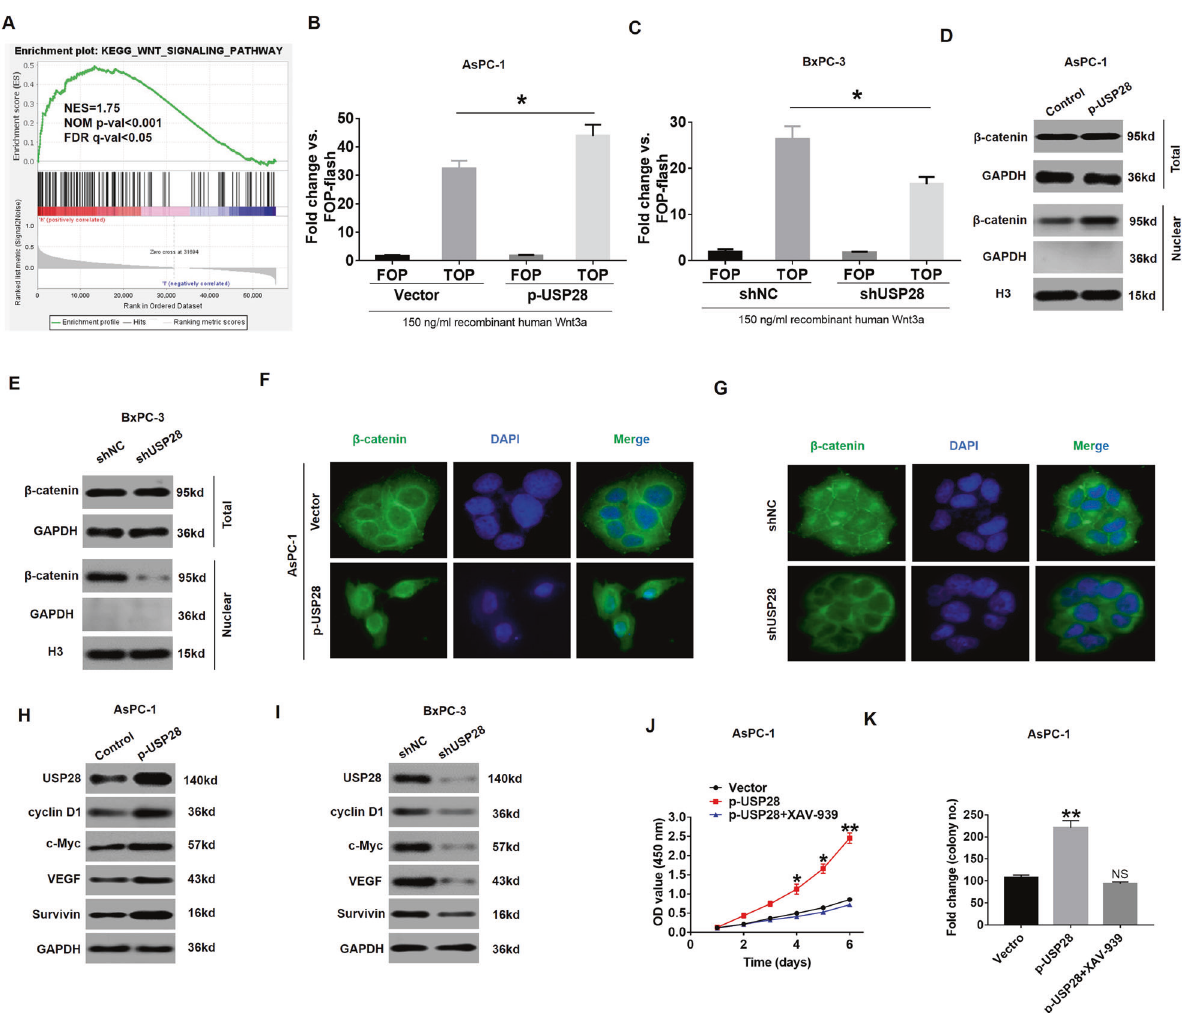
Fig. 4 USP28 activates Wnt/ β -catenin signalling pathway in PC cells. A GSEA comparing the gene sets of Wnt targets in USP28 high PC patients. Data were obtained from TCGA database. NES means normalized enrichment score. B , C After treatment with 150 ng/ml of recombinant human Wnt3a, the relative luciferase activity levels in cells transfected with TOP- fl ash and FOP- fl ash vectors in USP28- overexpression AsPC-1 cells ( B ) or USP28-silencing BxPC-3 cells ( C ) are shown. Data represent mean ± SD of triplicate experiments and were statistically analysed with Student ’ s t test, * P < 0.05. D , E The total and nuclear protein levels of β -catenin were assessed by western blotting in USP28-overexpression AsPC-1 cells ( D ) or USP28-silencing BxPC-3 cells ( E ). GAPDH and Histone 3 were used as a loading control, respectively. F , G IF analysis of the nuclear levels of the β -catenin in PC cell transduced with p-USP28 or shUSP28 plasmid. The green signal represents the staining of the corresponding protein, and the blue signal represents the nuclear DNA staining by DAPI. H , I Western blotting showing the protein expression of USP28, cyclin D1, c-Myc, VEGF and Survivin in USP28-overexpression AsPC-1 cells ( H ) or USP28-silencing BxPC-3 cells ( I ). GAPDH was used as a loading control. J , K Quanti fi cation for CCK-8 ( J ) or colony formation assays ( K ) of USP28-overexpression AsPC-1 cells transfected with XAV-939. * P <